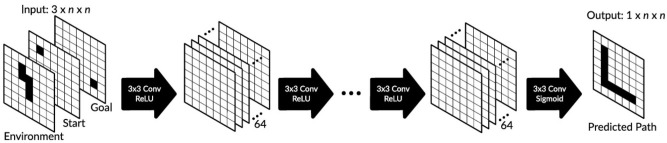
Proposed network architecture based on a fully convolutional neural network. If not otherwise mentioned, we used 21 convolutional layers with 3 × 3 filters (64 filters in layers 1–20 and one filter in the last layer). We used ReLU activation units in all but the last layer where sigmoid activation units were used.